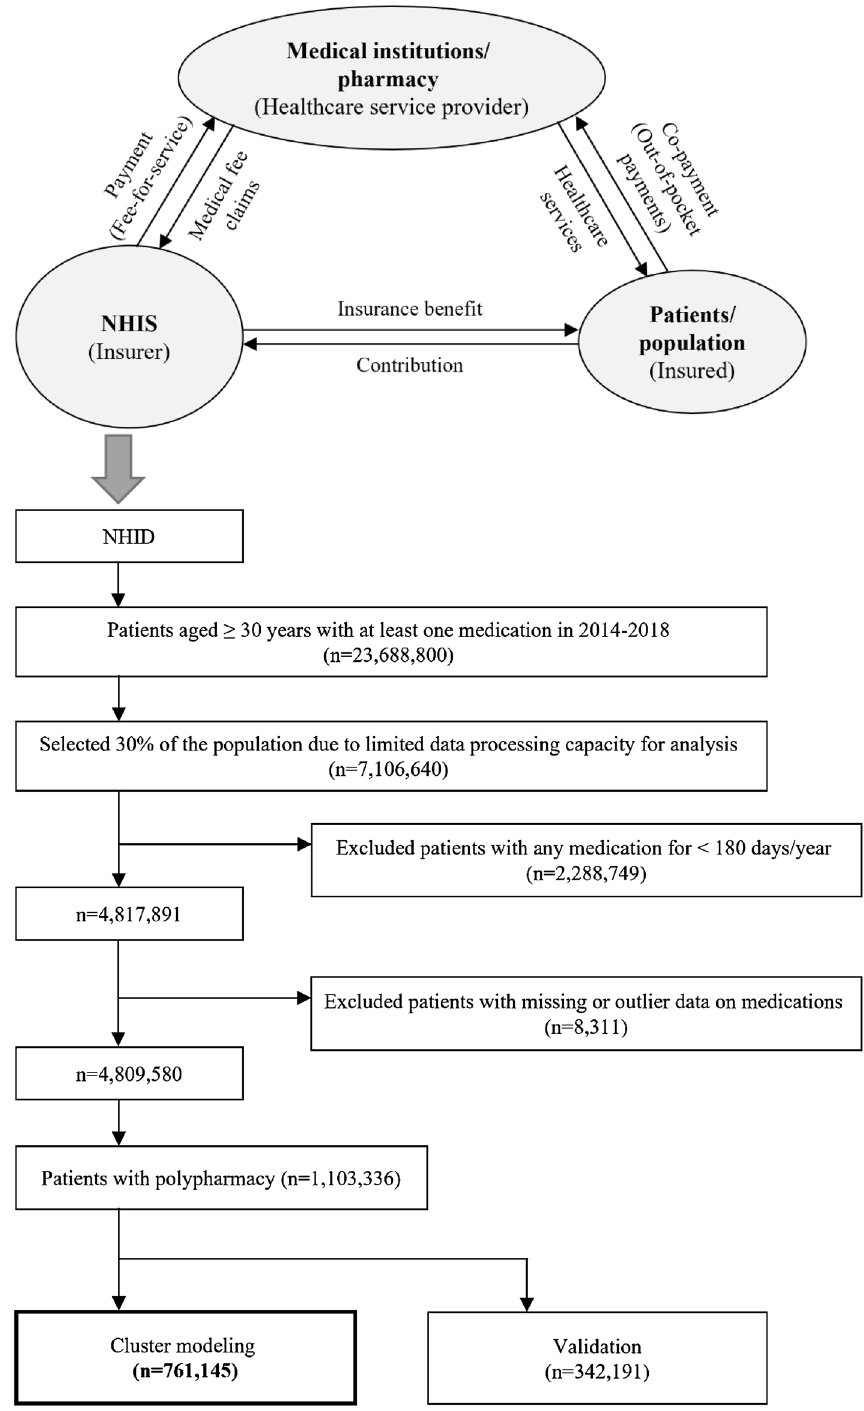
Figure 4. The structure of the National Health Insurance program in Korea and this study population data obtained from the NHID. NHID National Health Information database, NHIS National Health Insurance